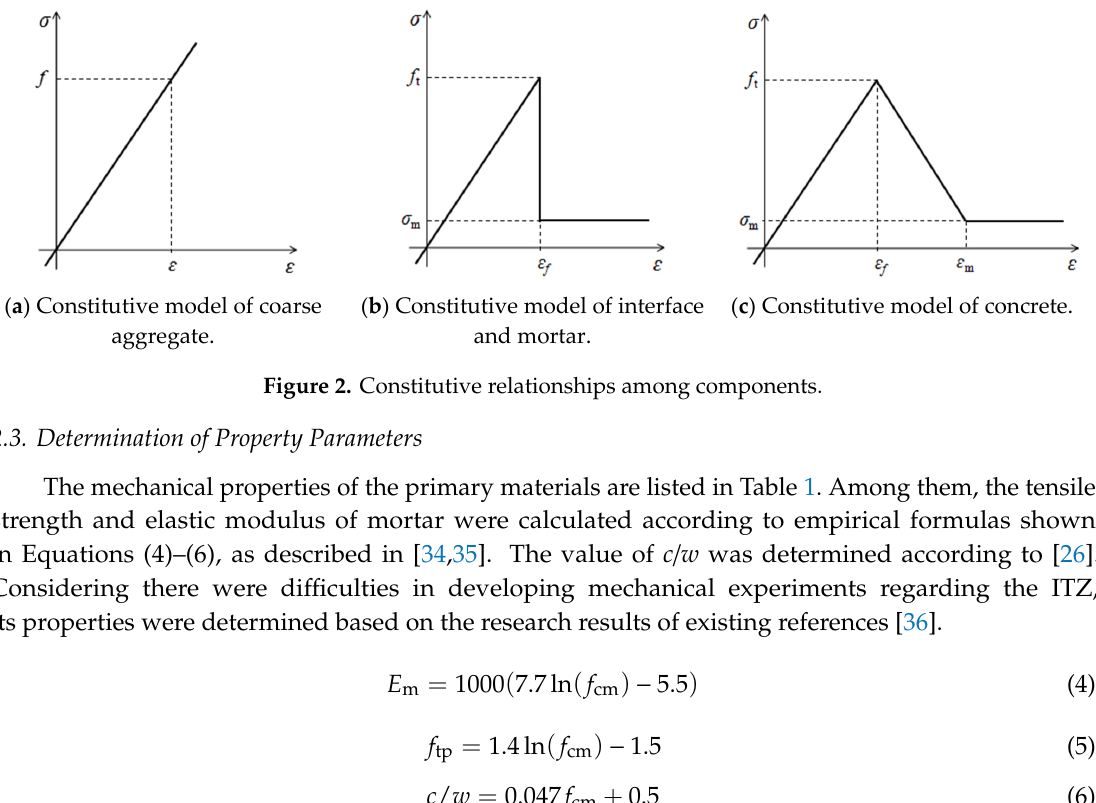
Table 1. Properties of primary materials.